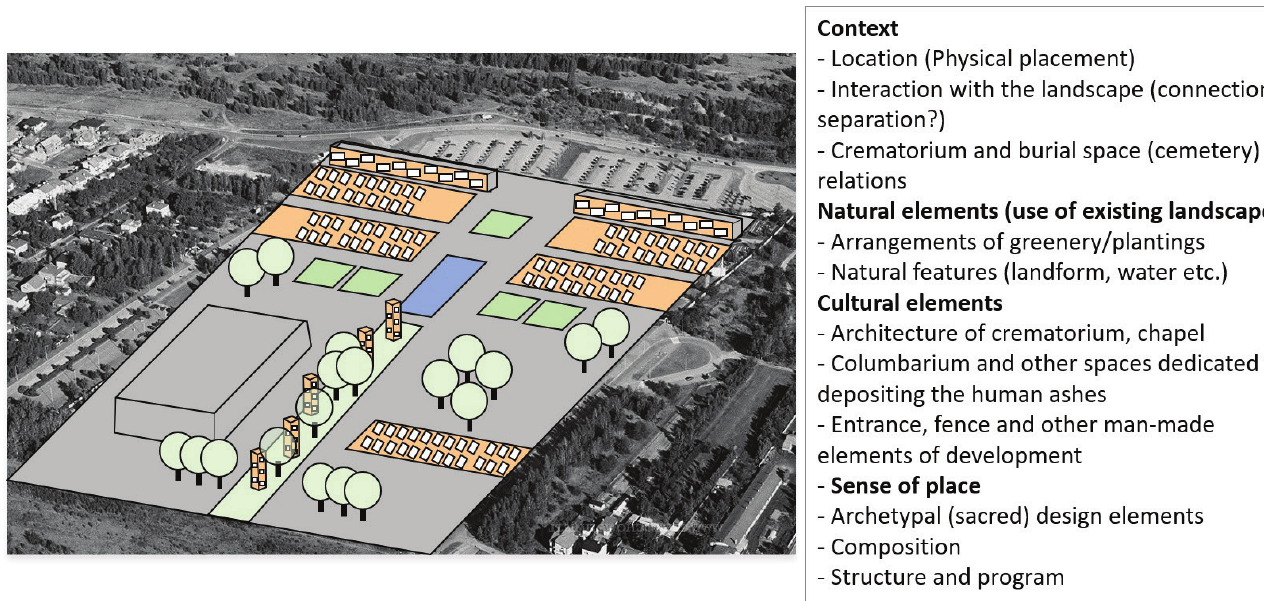
Figure 7. Four layers of multifaceted landscape as a basis for identification of design solutions. Own elaboration